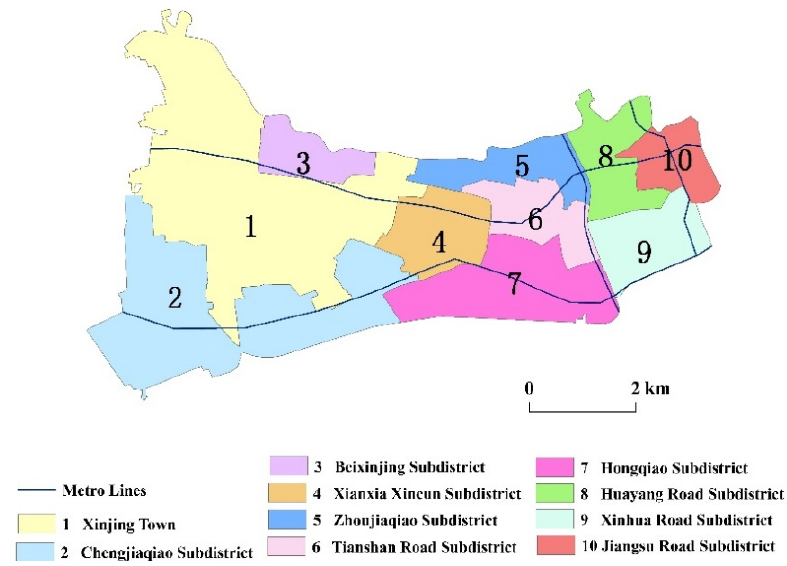
Figure 3. Overview of the study area.